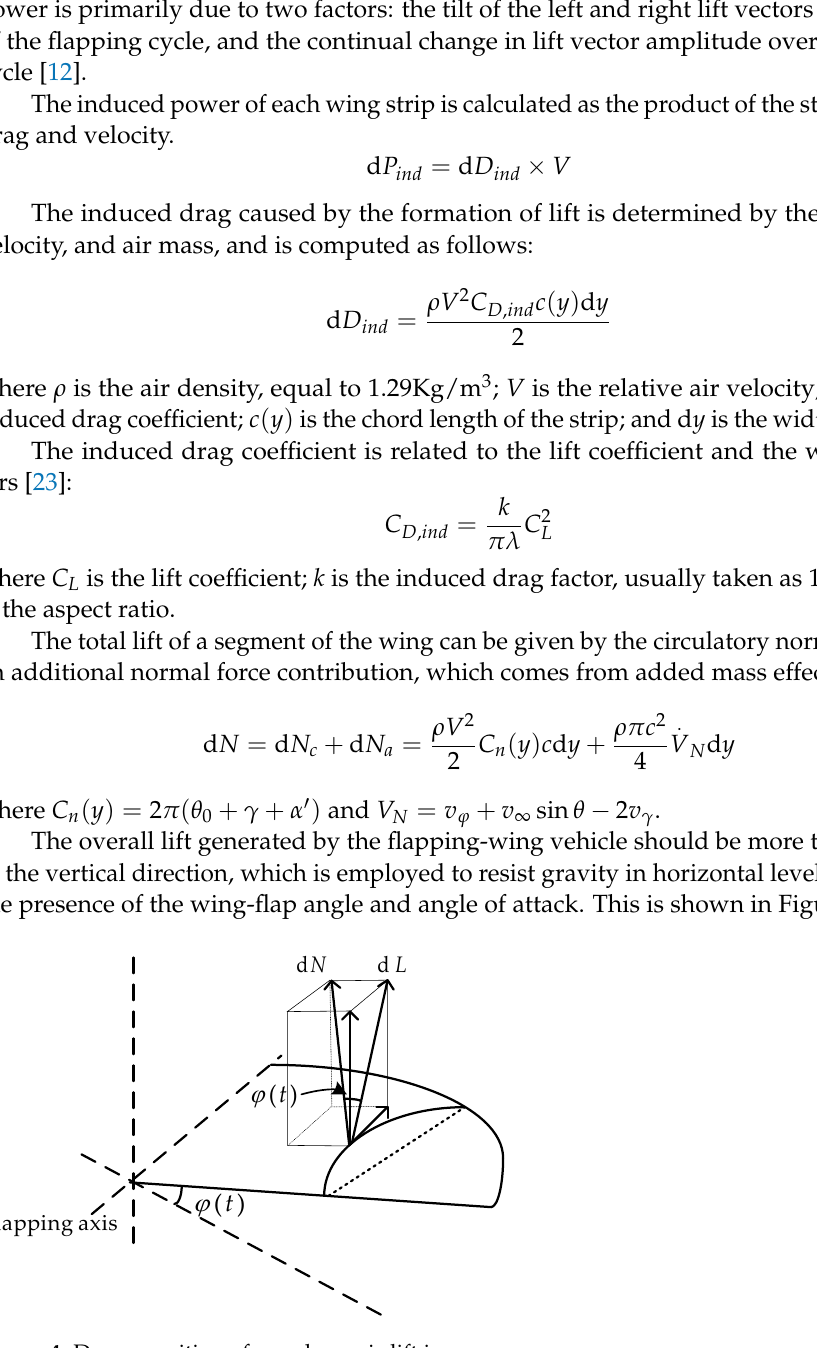
Figure 4. Decomposition of aerodynamic lift in space.